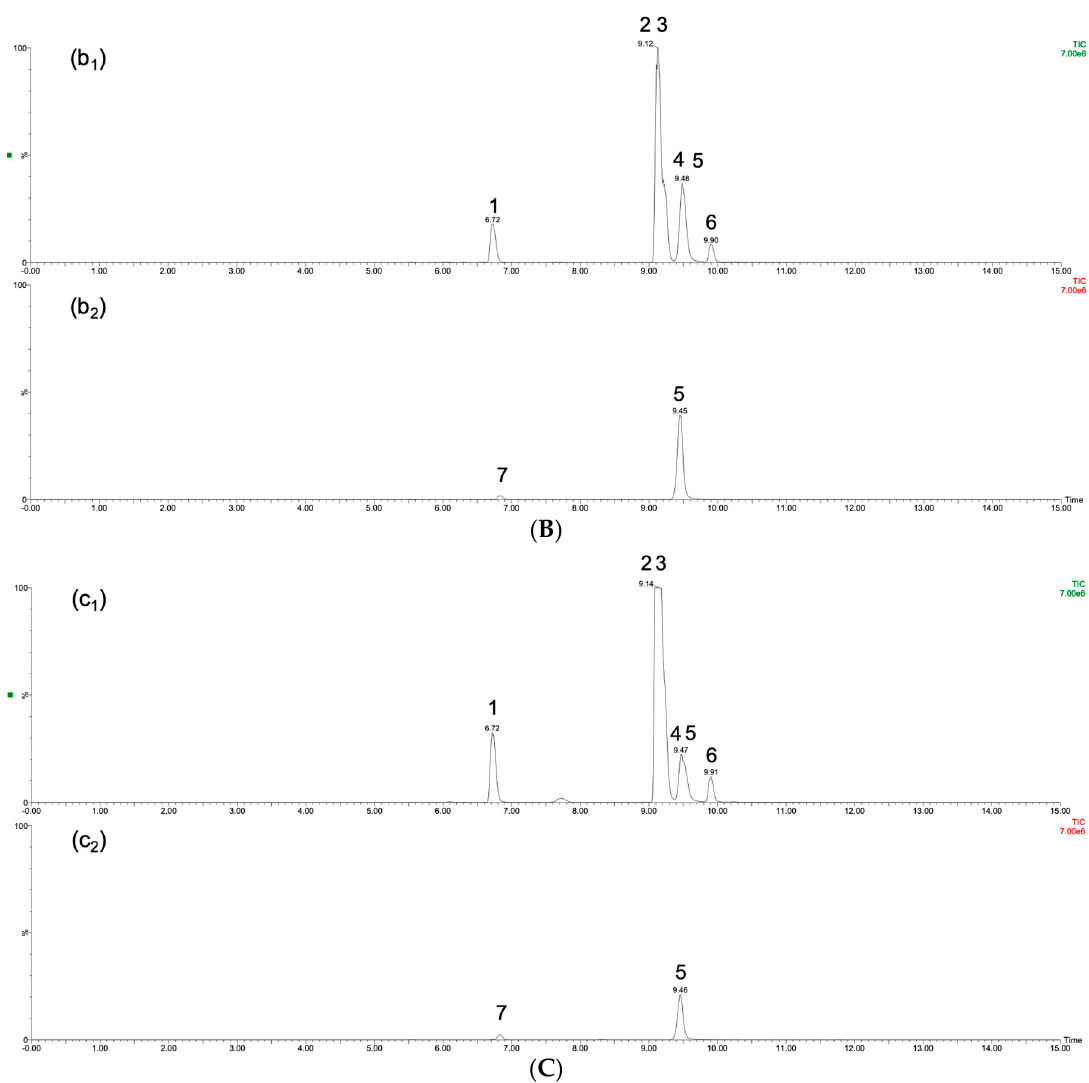
Figure 4. The TIC chromatographs of ( A ) The sample B of P. ginseng ; ( B ) The sample F of P. japonicus ; ( C ) The sample J of P. quinquefolius ; peak (1) ginsenoside Re (2) ginsenoside Rb 1 (3) ginsenoside Rb 2 (4) ginsenoside Rc (5) noscapine (internal standard) (6) ginsenoside Rd (7) ginsenoside Rg 1 .